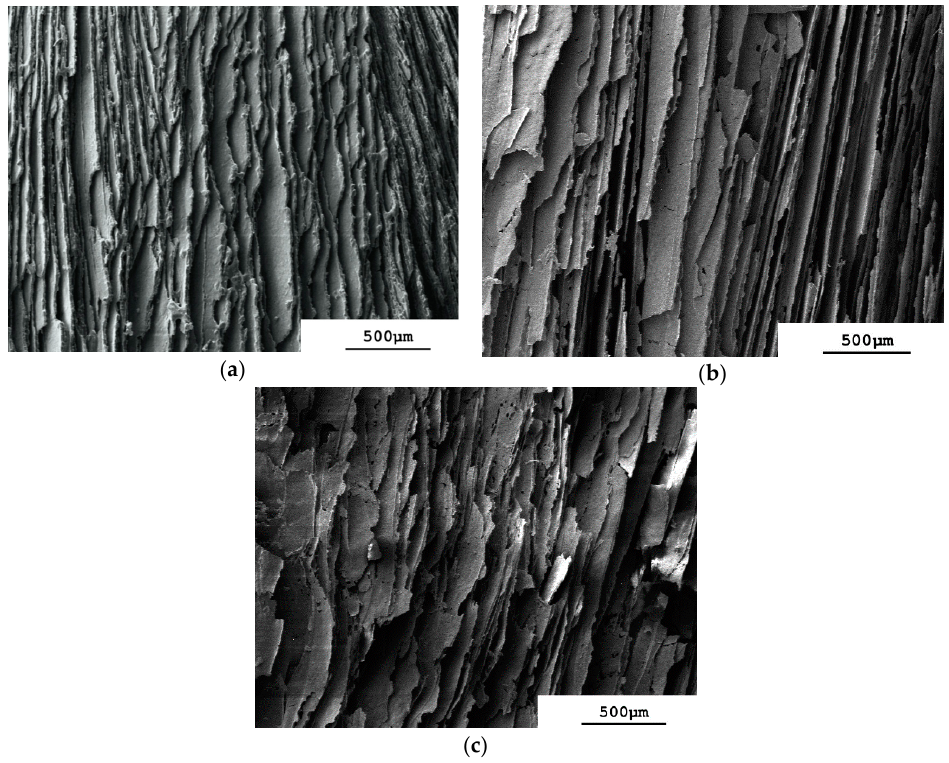
Figure 3. Scanning electron micrographs of longitudinal sectioned sintered monoliths to show central region of aligned lamellar pores. ( a ) φ v = 0.128; ( b ) φ v = 0.064; ( c ) φ v = 0.032. The aligned structure is altered in the base region of the sintered monoliths at all values of φ v . The aligned pores and lamellae are still identifiable almost right down to the vial base, but then transform to a more dense structure with low porosity close to the vial base. This base layer is thickest at φ v = 0.128 (Figure 4a) and becomes thinner as the slurry concentration is reduced through φ v = 0.064 (Figure 4b) to φ v = 0.032 (Figure 4c). It is clearly porous at φ v = 0.128 and 0.064, although this is less pronounced at φ v = 0.032. It differs therefore from the dense zone formed adjacent to the cold source of a liquid nitrogen-charged cold-finger [16]. With vacuum-induced surface freezing the rate of advancement of the freezing front [18] is evidently sufficient low to allow horizontal accumulation of the nanoparticles between the aligned lamellar ice crystals being formed, but not high enough to prevent some of the nanoparticles being pushed downwards. These then accumulate as a layer at the base at the end of the freezing process. Recall that with vacuum-induced surface freezing the freezing front moves from top to bottom and not from bottom to top as in regular freeze casting with a liquid nitrogen-charged cold-finger [16]. This explains why this layer has low porosity and its height is a direct function of slurry concentration. The formation of a close-packed, cohesive layer of coagulated, rejected nanoparticles has been observed in the unfrozen region ahead of the freezing front at low freezing rates of alumina slurries ( ≤ 3 µm/s) [26,27]. This was associated with ice segregation as crack-like ice-lenses. Yet the dense base-layers observed in Figure 4a–c differ from this behavior in that they are formed at higher freezing rates (estimated to be up to 30 µm/s [18]). Additionally, the region directly adjacent to the dense base-layer, i.e., that formed from the segregated ice crystals, is the aligned lamellar region, where no indication of an ice-lens morphology is observed. Note that the effects of gravity in forming this dense base layer will be weak. Stokes’ Law for a non-interacting sphere falling through a fluid gives a sedimentation rate of 310 nm/s for the alumina nanoparticles through water at 10 °C, which is only one-hundredth part of the estimated initial rate of advancement of the freezing front during vacuum-induced surface freezing [18].